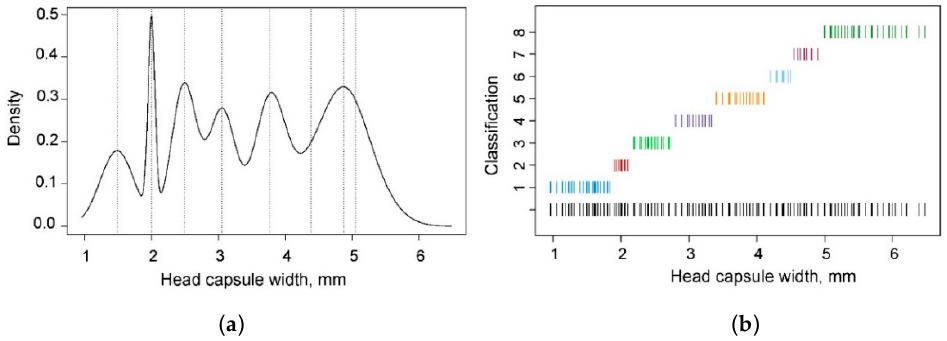
Figure 5. The results of clustering for the head capsule widths of Dendrolimus pini larvae based on the eight-component model (separating eight instars): ( a ) density (means are indicated by dotted lines) and ( b ) classification.